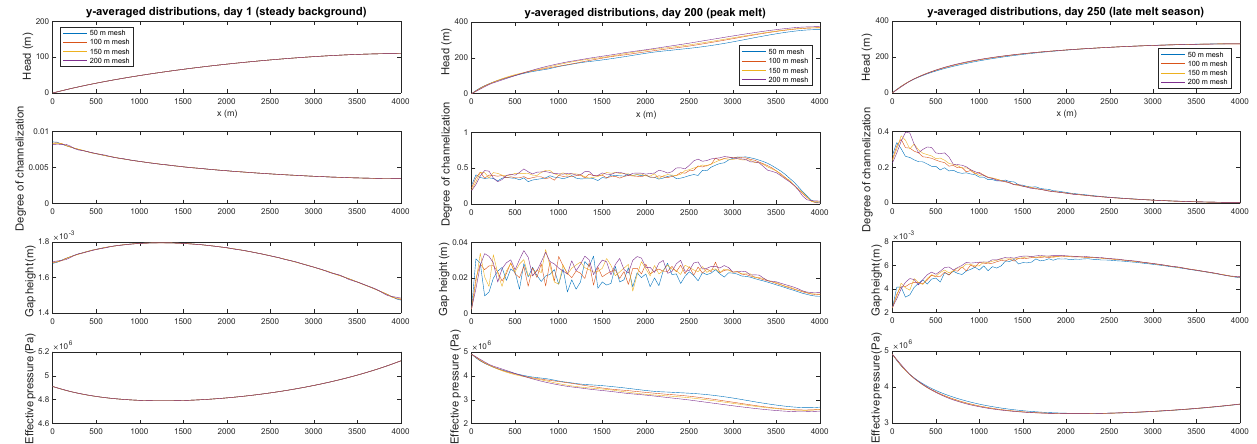
Figure 8. Mesh dependence shown with y -averaged quantities for the transient example (see Sect. 3.3 and Figs. 5–7) for three selected days. The model has very little dependence on mesh size with sheetlike drainage (day 1). With channelization (day 200 at the peak of the input and day 250 with some channelization), mesh size leads to variability in the highly channelized regions. The local differences are more pronounced in the quantities calculated over elements (gap height and degree of channelization), while differences are relatively small in the smooth pressure distributions calculated at the vertices of the